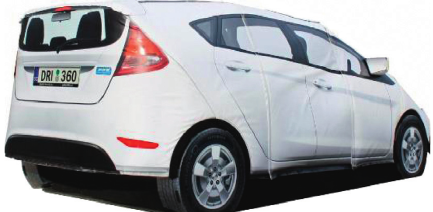
Figure 1: Specification of GVT.